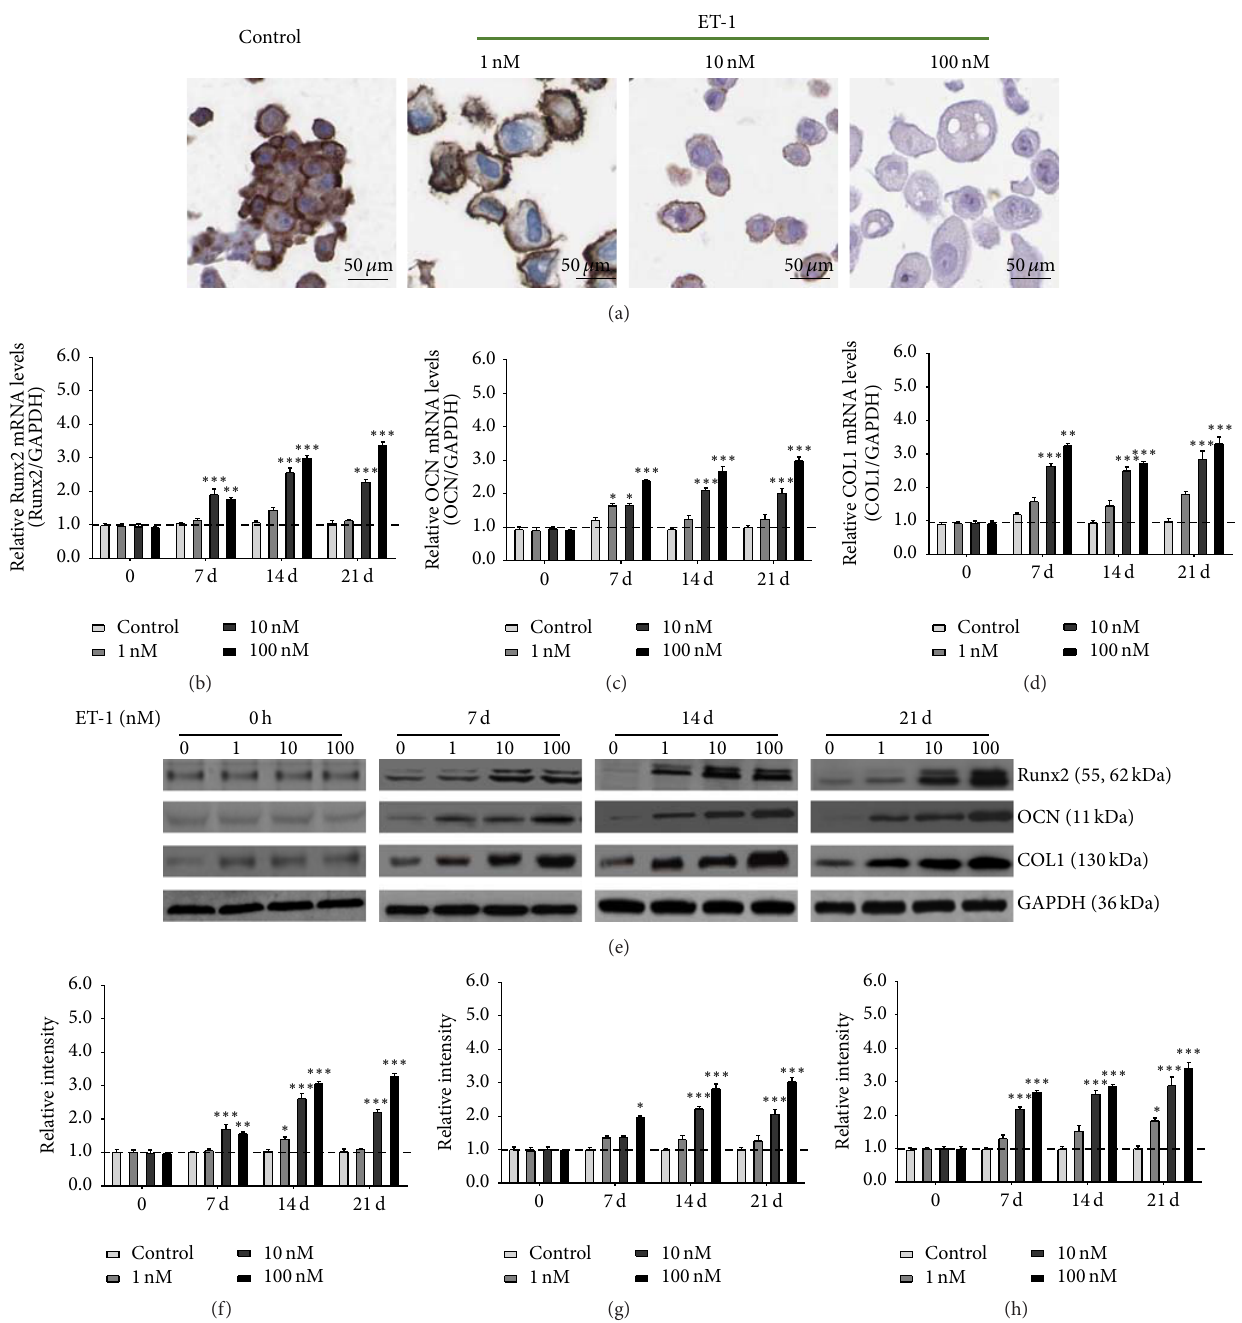
Figure 2: ET-1 promoted differentiation of PDLSCs into osteoblasts by increasing expression of Runx2, OCN, and COL1. The osteogenic potential of PDLSCs was tested using ALP staining. Increased ALP activity is a marker of osteoblast differentiation. The staining showed that ET-1 promoted differentiation of PDLSCs into osteoblasts (a). Runx2, OCN, and COL1 mRNA levels gradually increased with the exposure of ET-1, peaking at day 21 ( 𝑃 < 0.05 ). At each time point (7d, 14d, and 21 d), the expression of Runx2 (b), OCN (c), and COL1 (d) mRNAs was induced at a dose-dependent manner (1, 10, and 100nM). The effect of ET-1 on osteogenic differentiation of PDLSCs was further verified by assessing the change in Runx2, OCN, and COL1 expression of proteins associated with osteogenesis. Runx2 ((e), (f)), OCN ((e), (g)), and COL1 ((e), (h)) protein expressions levels were coincident with the mRNA changes. Each bar represents the mean ± standard